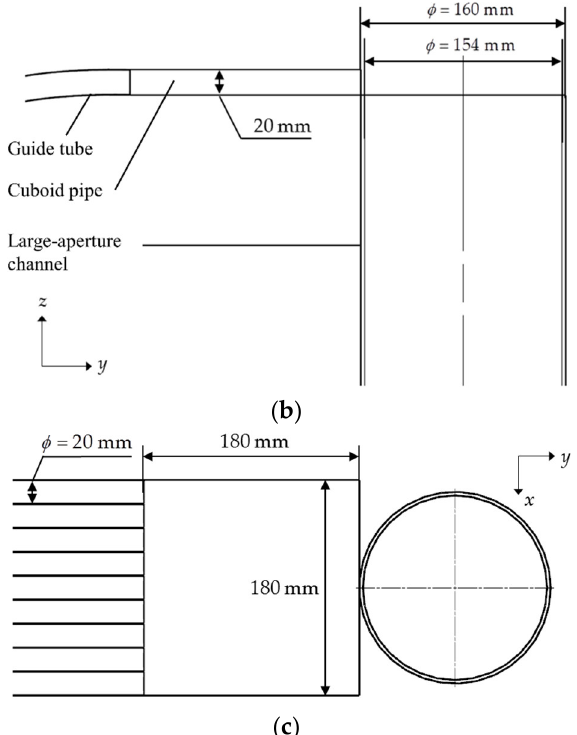
Figure 1. Three blowing scheme models for large-aperture channel sealing. ( a ) The overall structure scheme model; ( b , c ) the structure and location of the outlet of the radial blowing